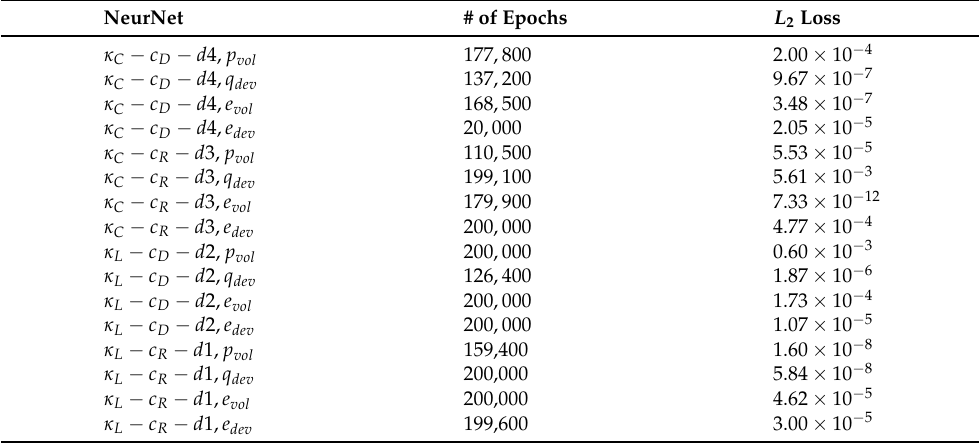
Table 6. Number of epochs for convergence and the corresponding L 2 loss for Neural Networks for Monte Carlo simulations of non porous